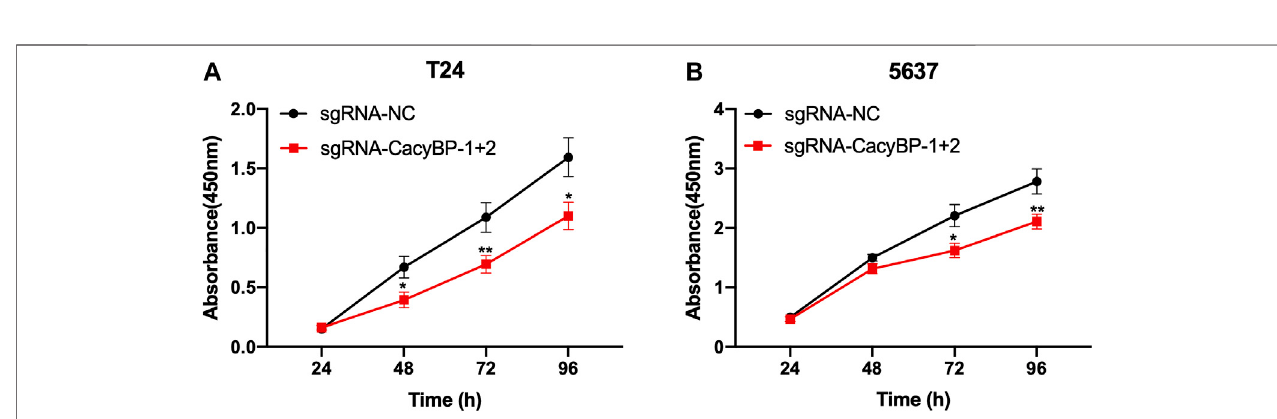
FIGURE3| Downregulation ofCacyBP inhibited theproliferation ofbladder cancer cells (A, B) CCK-8 assaysofT24and 5,637 cells after transfectedwith dCas9- KRAB and sgRNAs. * p < 0.05, ** p < 0.01.